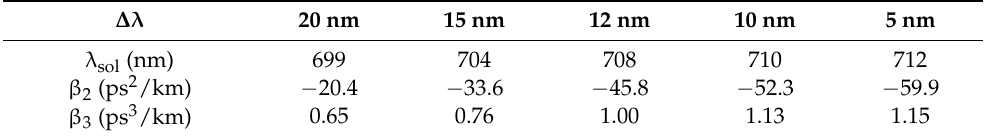
Table 1. Dispersion parameters β 2 and β 3 ( β ( ω ) come from the numerical simulation (COMSOL)) at soliton wavelengths (taken from the experiments, Figure 3a–e) for different spectral distances ∆ λ . ∆